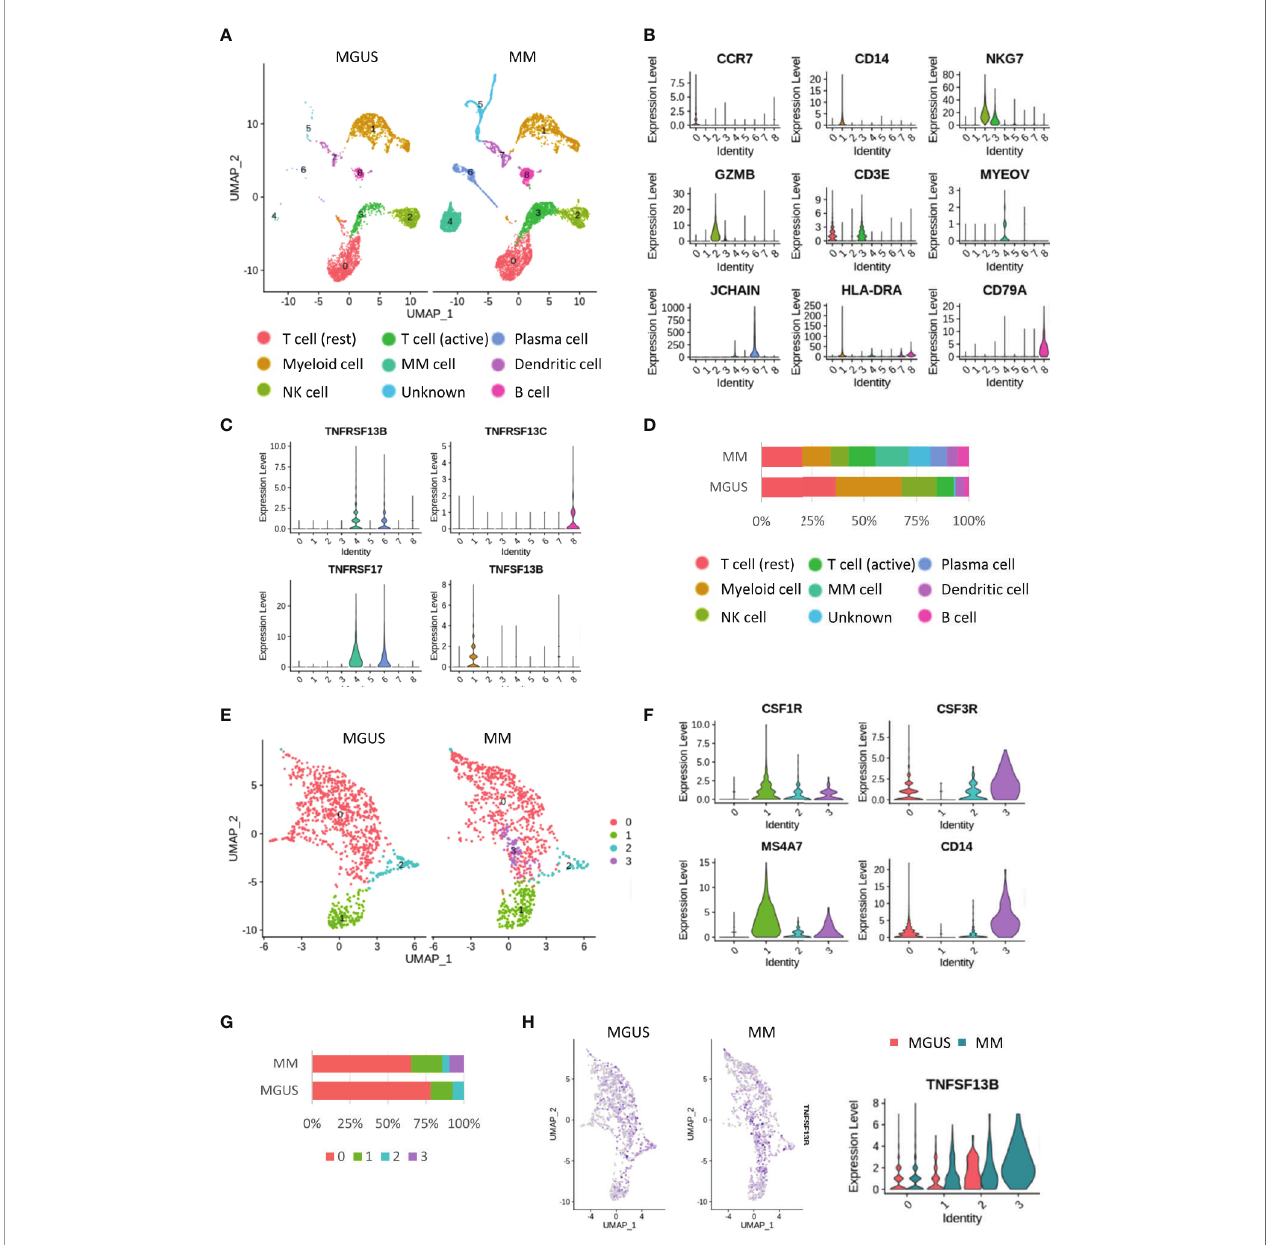
FIGURE 1 | Single cell RNA-seq analysis in the MGUS and MM sample. (A) UMAP diagram shows the nine main cell types in the MGUS and MM samples. (B) Violin plots indicate the expression and distribution of marker genes in T cells, myeloid cells, NK cells, DCs, plasma cells, myeloma cells, and B cells. (C) Violon plots show the expression of TNFSF13B and its receptors on the plasma cell and myeloma cells. (D) In bar charts, the proportion of single cell data of MGUS and MM sample patients is quanti fi ed and compared. (E) UMAP diagram shows the subclustering of myeloid cells. (F) Violin plot indicates the different genes of neutrophil and macrophages. (G) In bar charts, the proportion of neutrophil and macrophages in the MGUS and MM sample is quanti fi ed and compared. (H) Feature plots demonstrate the projection of TNFSF13B expression onto the neutrophil and macrophages. Violin plots indicate the levels of TNFSF13B expression in the myeloid cells of MGUS and MM